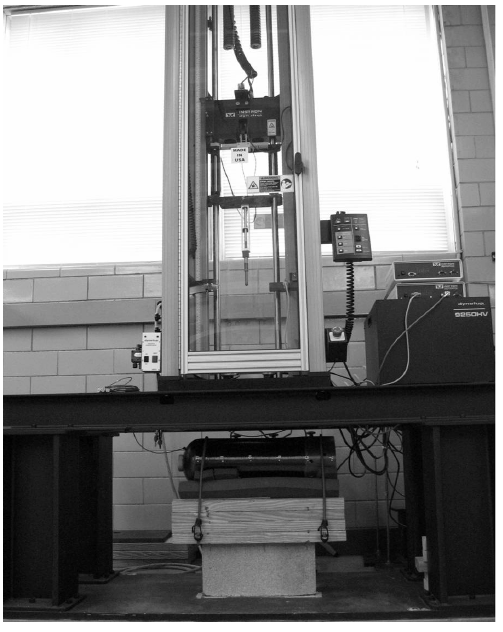
Fig. 19. The RMC and wooden block is placed below the main cabinet of the drop tower for testing damaging impacts.